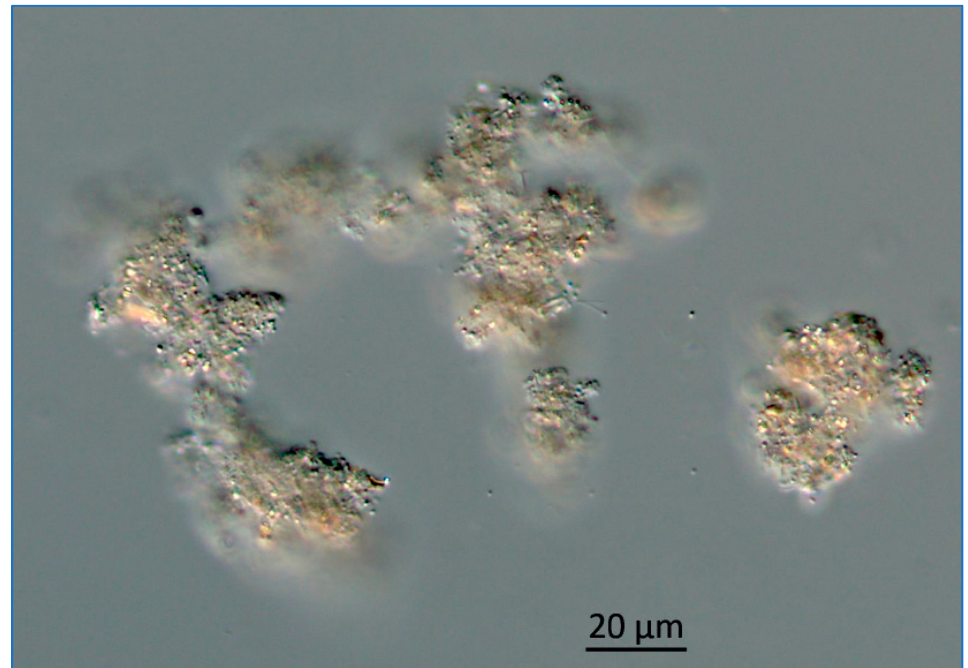
Figure 13. Photomicrograph of Lake Okeechobee snow collected from 1.8 m below the surface, June 2020. The image was obtained using a Zeiss AX10 microscope equipped with DIC and a digital imaging system.